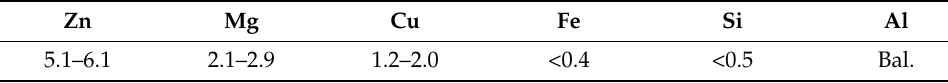
Table 1. Chemical compositions of 7075 Al alloy